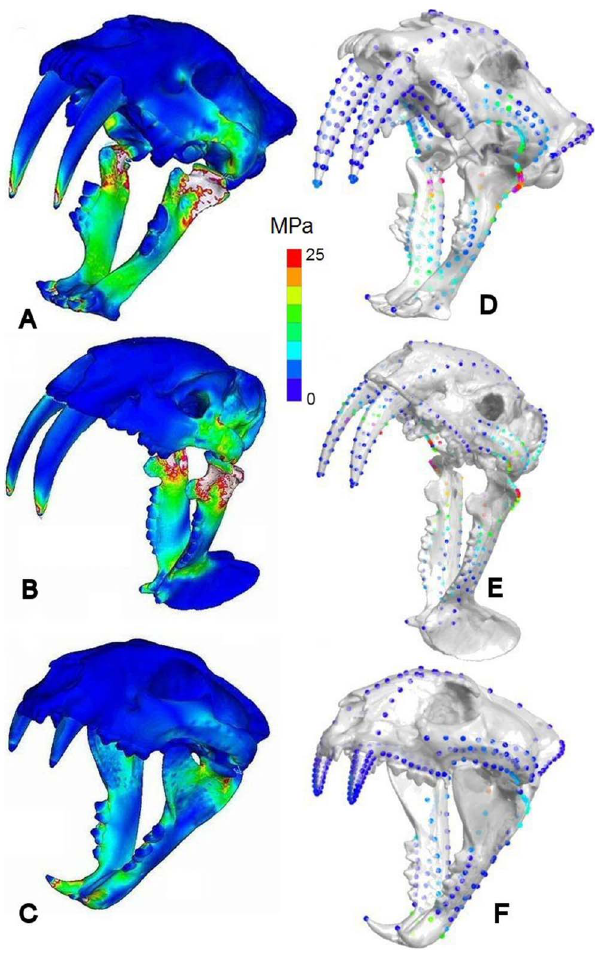
Figure 2. Stress distributions in scaled models for jaw adductor driven bites. Von Mises stress distributions and mean landmark point VM stresses given respectively for (A & D) Smilodon fatalis , (B & E) Thylacosmilus atrox , (C & F) Panthera pardus. MPa=Megapascals. Muscle forces scaled to bite reaction forces predicted on the basis of body mass.